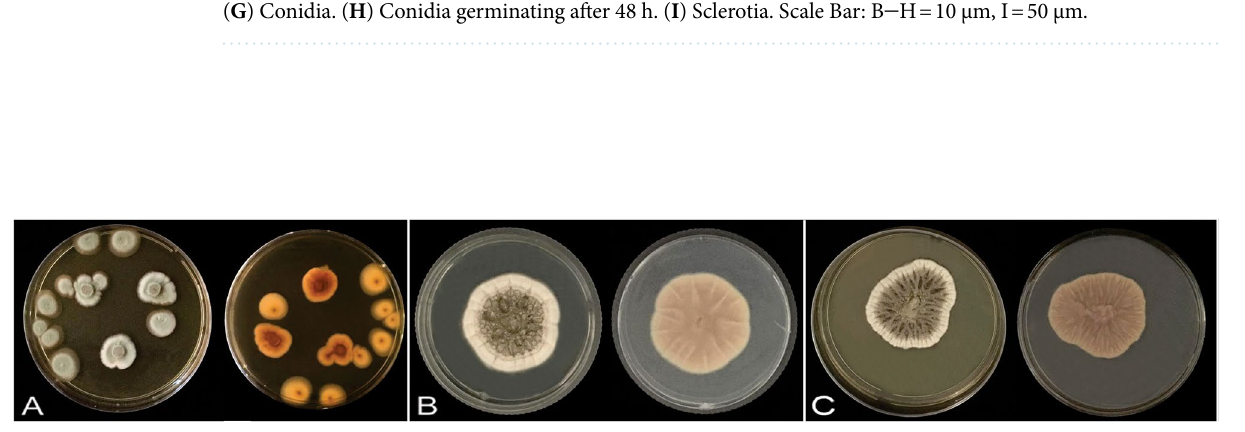
Figure 3. Colony morphology of seven-day-old cultures of Penicillium cerradense sp. nov. grown on MEA ( A ), PDA ( B ) and SDA ( C ) at 25 ± 2 °C. Surface and reverse from left to